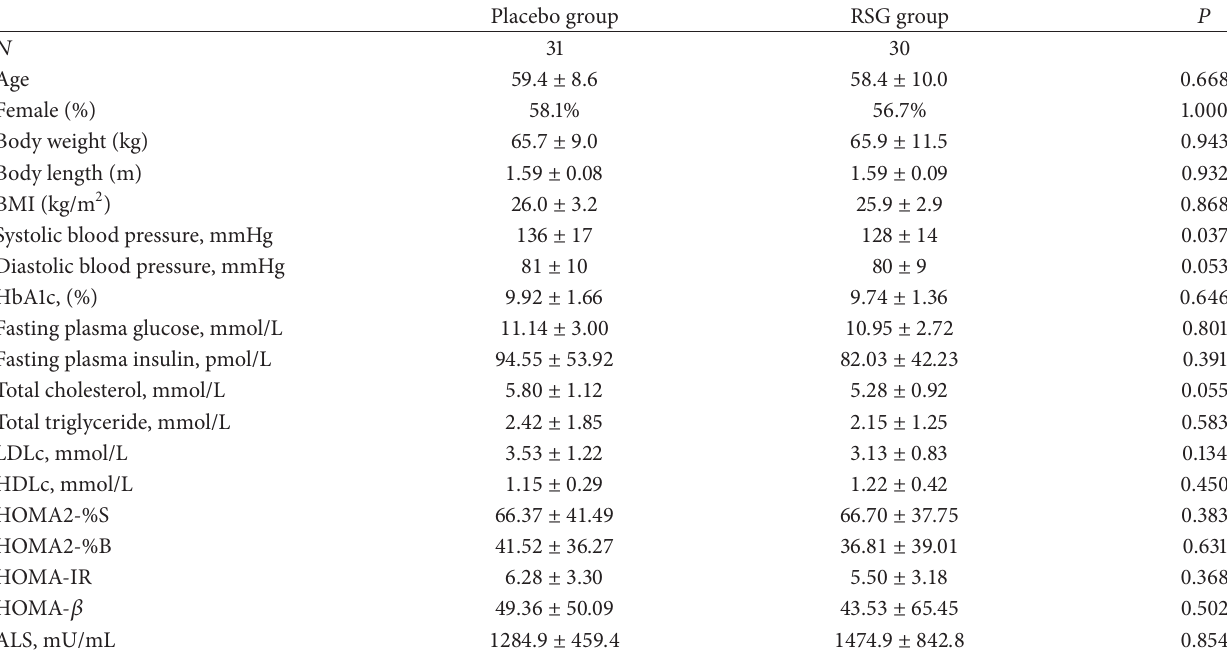
Table 1: Clinical characteristics of the study subjects at baseline.